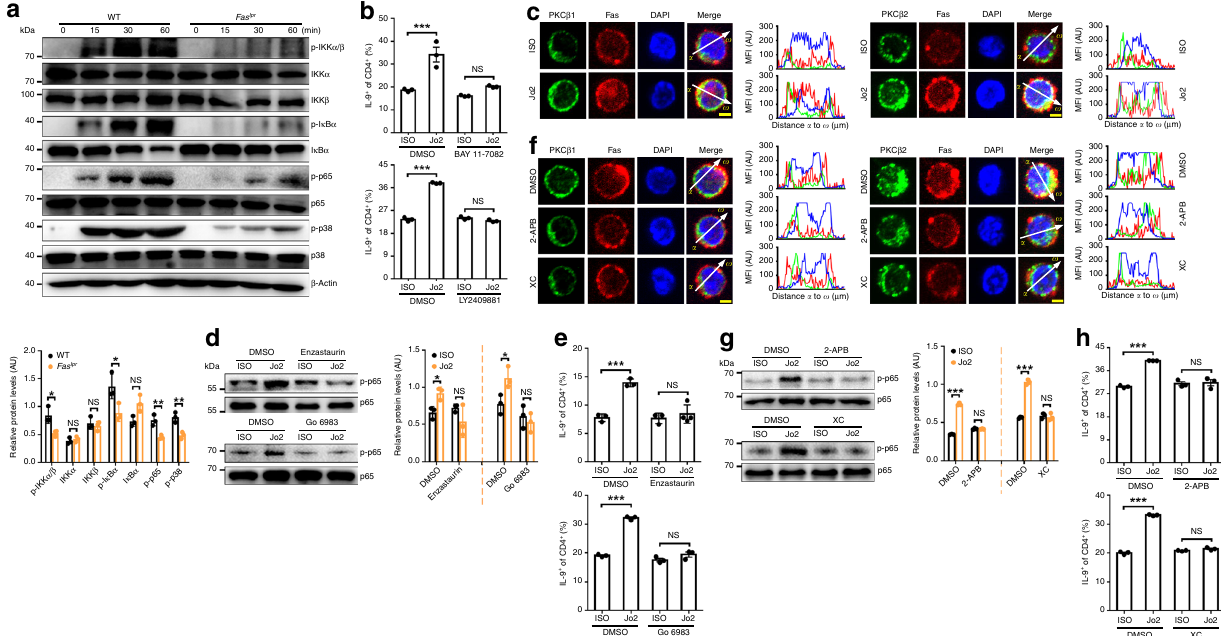
Fig. 3 Fas signaling induces T helper type 9 (T H 9) cell generation by activating nuclear factor- κ B (NF- κ B). a Western blotting analysis of the indicated proteins in wild-type (WT) or Fas lpr CD4 + T cells under T H 9-skewing conditions at the indicated time points (top), and statistical analysis of the relative protein levels at the 60 min (bottom). b Flow cytometric analysis of the frequency of IL-9 + (interleukin-9 + ) cells among CD4 + T cells after the stimulation of naive CD4 + T cells with 10 μ g ml − 1 ISO or Jo2 with or without 0.4 μ M I κ B α inhibitor BAY 11-7082 or 0.5 μ M IKK2 inhibitor LY2409881 under T H 9- skewing conditions for 4 days. c Immuno fl uorescence staining of protein kinase C β (PKC β 1) or PKC β 2 with Fas in naive CD4 + T cells stimulated with 10 μ g ml − 1 ISO or Jo2 for 15 min under T H 9-skewing conditions. d Western blotting analysis of p-p65 protein levels in naive CD4 + T cells stimulated with 10 μ g ml − 1 ISO or Jo2 for 15 min with or without 0.5 μ M PKC β inhibitor enzastaurin or 0.01 μ M pan-PKC inhibitor Go 6983 under T H 9-skewing conditions (left), and statistical analysis of the relative protein levels (right). e Flow cytometric analysis of the frequency of IL-9 + cells among CD4 + T cells after the stimulation of naive CD4 + T cells with 10 μ g ml − 1 ISO or Jo2 with or without 0.5 μ M enzastaurin or 0.01 μ M Go 6983 under T H 9-skewing conditions for 4 days. f – h Immuno fl uorescence staining of PKC β 1 or PKC β 2 with Fas ( f ), western blotting analysis of p-p65 protein levels (left) and statistical analysis of the relative protein levels (right) ( g ), and fl ow cytometric analysis of the frequency of IL-9 + cells ( h ) in the naive CD4 + T cells stimulated with 10 μ g ml − 1 Jo2 with or without 10 μ M inositol 1,4,5-trisphosphate-induced Ca 2 + release inhibitor, 2-aminoethoxydiphenyl borate (2-APB) or xestospongin C (XC) for 15 min ( f , g ) or 4 days ( h ) under T H 9-skewing conditions. Scale bar = 2 μ m. AU, arbitrary units; NS, not signi fi cant; * P < 0.05, ** P < 0.01, *** P < 0.001 (unpaired Student ’ s t test). Representative results from three independent experiments are shown (mean and s.d.) ( n = 3). Relative protein levels = the indicated protein gray value/ β -actin ( a ) or p65 ( d , g ) gray